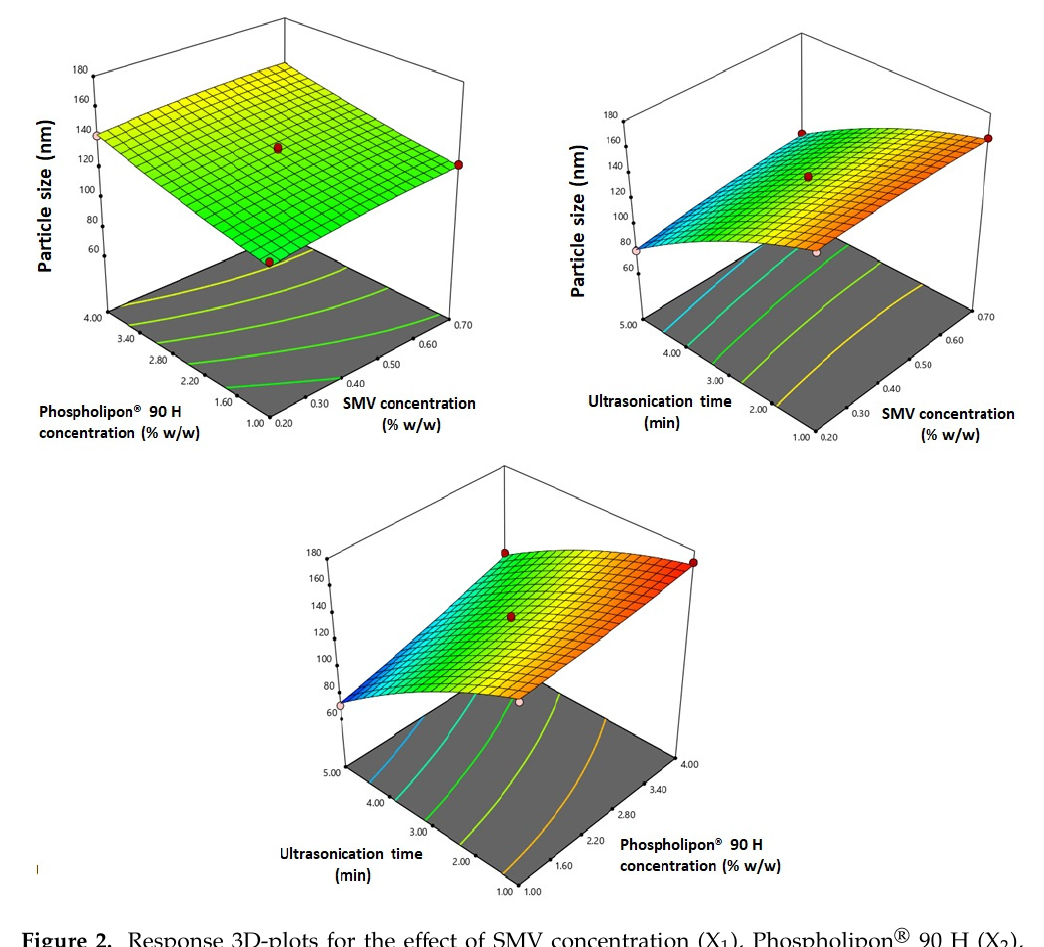
Figure 2. Response 3D-plots for the effect of SMV concentration (X 1 ), Phospholipon ® 90 H (X 2 ), and ultrasonication time (X 3 ) on the vesicle size of SMV-EMLs.